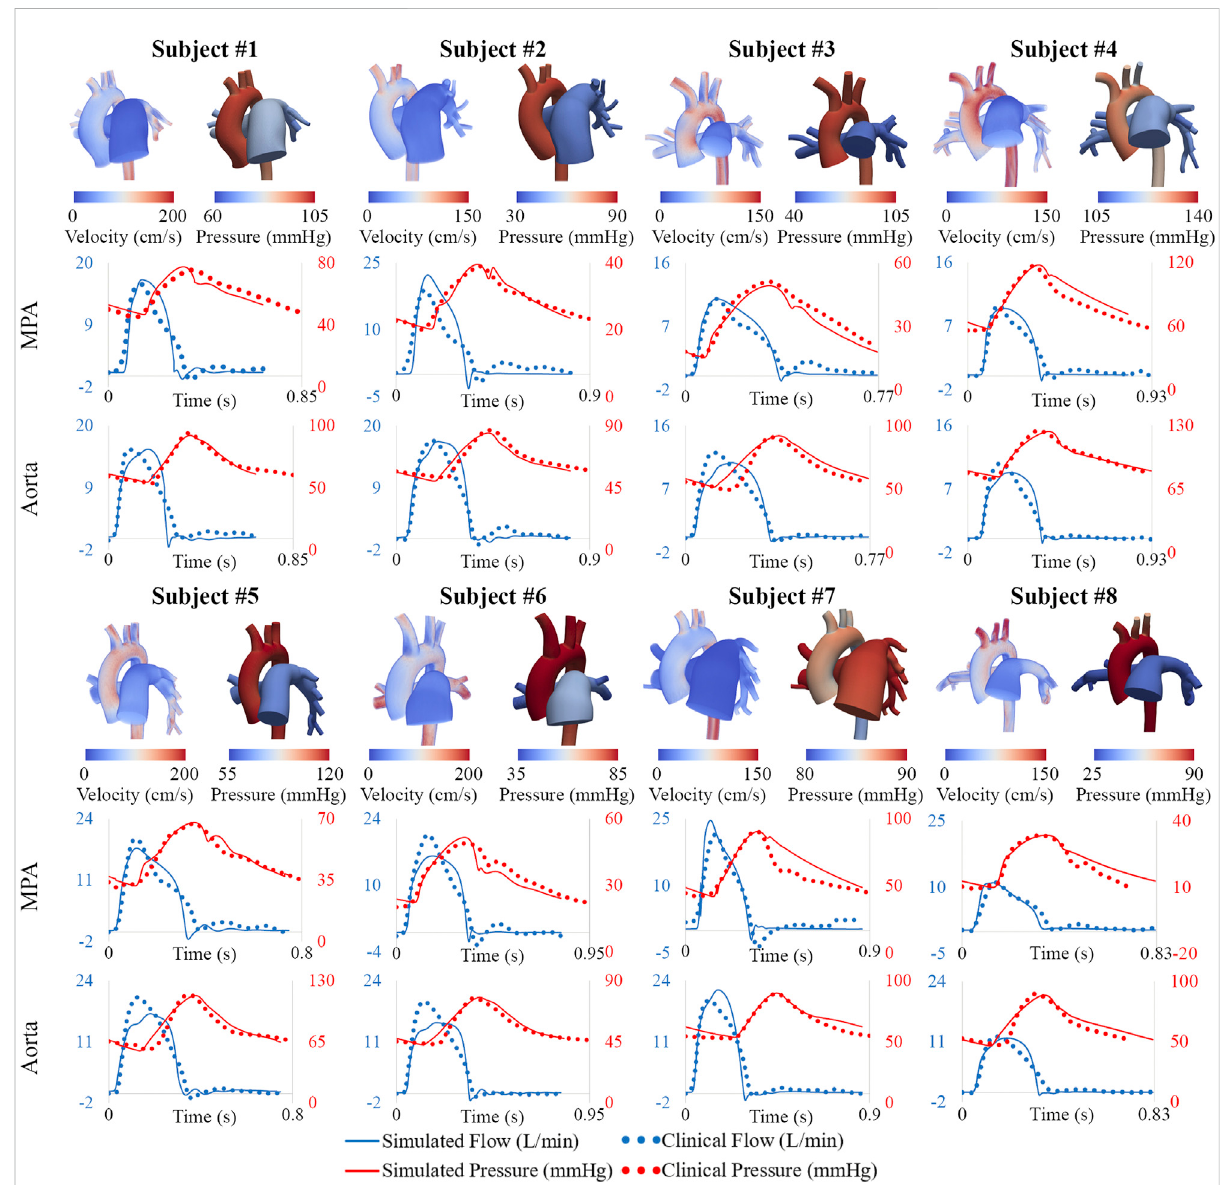
FIGURE 8 Velocity and pressure maps of the high-resolution arterial models at peak systole. Hemodynamic comparison shows agreement between simulated and clinical